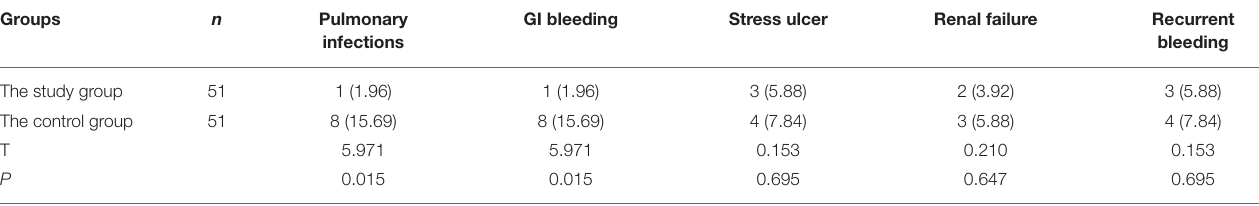
TABLE 3 | Comparison of postoperative complications and recurrent bleeding in the two groups, n (%). Groups n Pulmonary GI bleeding infections